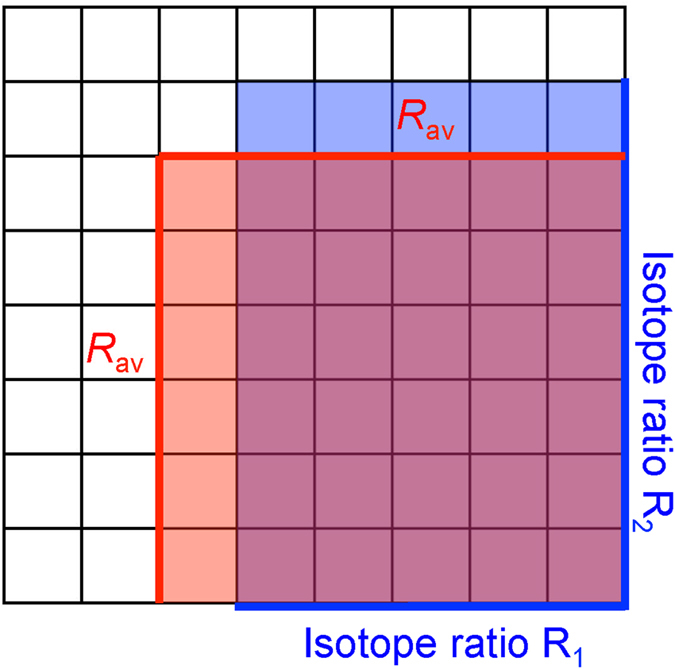
Geometric interpretation of the apparent statistical clumped isotope signatures.The quantity iRcl,random that is used as a reference to calculate Δi (Equation 3) is the product of the individual isotope ratios R1 and R2, indicated by the blue lines and blue area. However, for indistinguishable atoms in a molecule the individual ratios R1 and R2 cannot be determined independently, and they are both assigned the average ratio Rav (red lines). This leads to the red area for iRcl,random. The systematic error associated with using the red area instead of the blue area to calculate Δi causes the apparent negative clumped isotope signatures described in this paper.